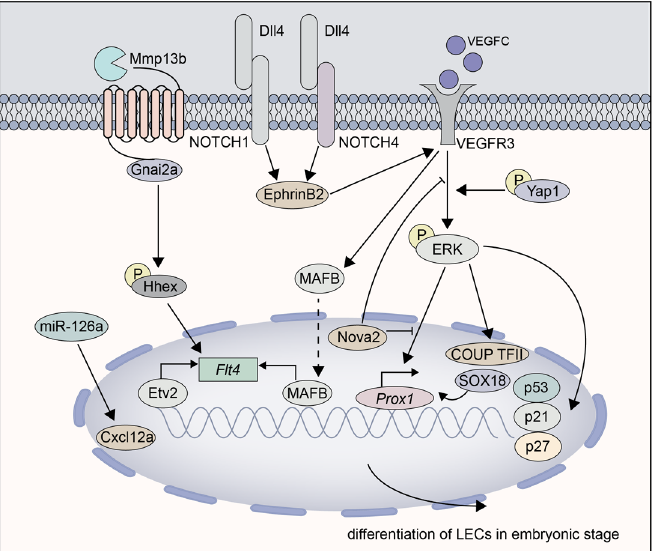
Figure 2. The molecular pathways involved in LEC differentiation from embryonic progenitors. (1) The mmp13b-par1-gnai2a axis activates VEGF-C/VEGFR3/ERK1/2 signaling through HHEX, which induces Prox1 expression and promotes the lymphangiogenesis; (2) Prox1, COUP-TFII, and SOX18 synchronously bind to the endogenous cyclin E1 promoter and interact with the differentiation and maintenance of LEC feature; (3) The expression of p53, p21, and p27 significantly promote the lymphatic sprouting in response to VEGF-C/VEGFR3 stimulation; (4) Dll4/NOTCH1/NOTCH4 axis regulates the expression of VEGFR3 via EphrinB2/Ras/MAPK signaling pathways; (5) The inhibitory splicing program Nova2 and effector Yap1, respectively, suppress or promote VEGFR3/ERK signaling pathway; (6) MAFB or Etv2 directly regulates the Prox1 and Flt4 expression; (7) miR-126a/Cxcl12a and VEGF-C/Flt4 signaling pathways cooperate and jointly direct LECs sprouting and extension.